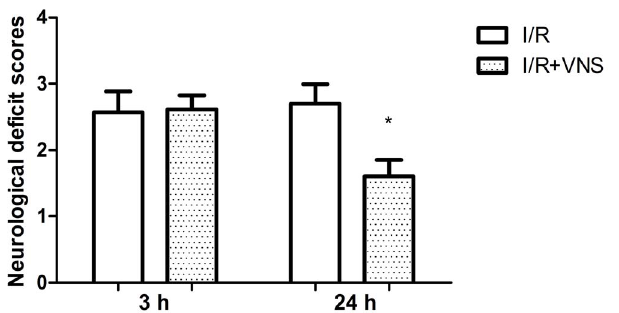
Figure 5. Neurological deficit scores after I/R with and without VNS. Bar graphs show the neurological deficit scores at 3 and 24 h following reperfusion in the three groups. Data are shown as mean 6 SEM *p , 0.05.